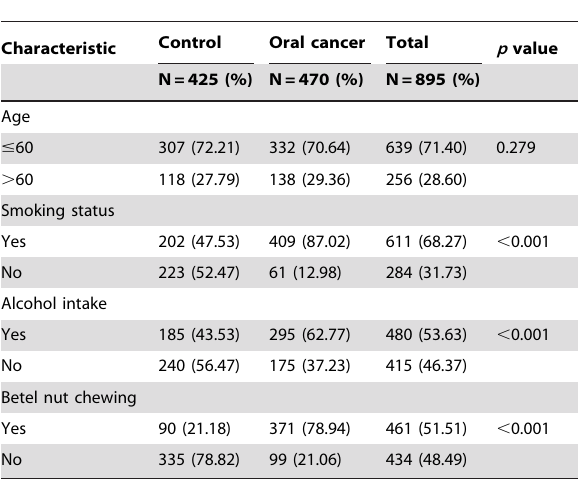
Table 1. Demographical characteristics in 425 healthy controls and 470 patients with oral cancer.